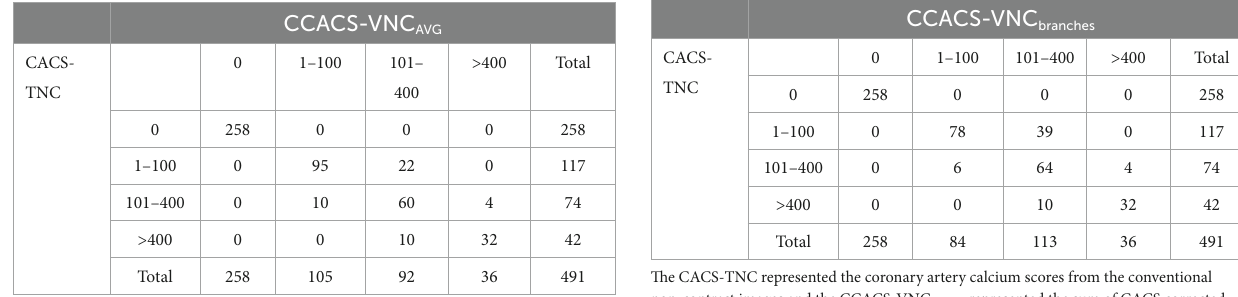
FIGURE 7 The Bland–Altman plot was used to describe the agreement of coronary artery calcium score between the non-contrast images and virtual non- contrast images (corrected by the corresponding regression equation of each coronary branch). Average 1 represented the mean value of calcium scores from two images, and difference1 represented the different values of calcium score from two images. Panel (A) depicts LM = left main coronary artery, panel (B) depicts LAD = left anterior descending branch, panel (C) depicts LCX = left circumflex branch, and panel (D) depicts RCA = right coronary artery.